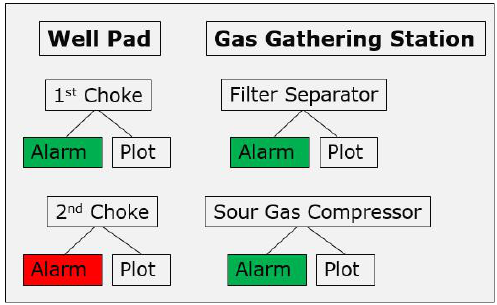
Figure 10—Conceptual schematic of real-time hydrate management and monitoring interface.